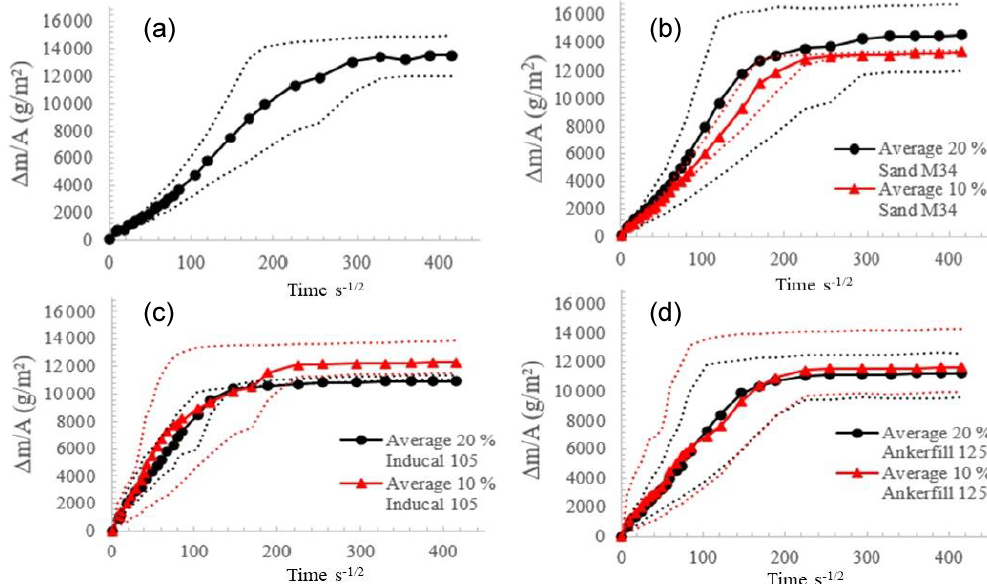
Figure 5. Capillary water absorption of the recipes (a) average “30Ca4” , (b) comparison Sand 10% and 20%, (c) comparison Inducal 105